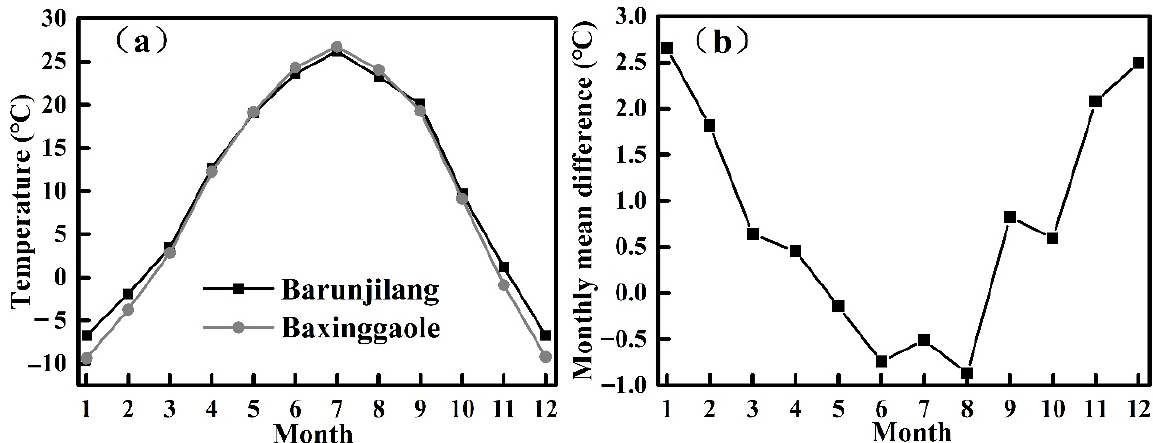
Figure 6. Annual temperature changes ( a ), monthly mean differences ( b ) in the lake and non-lake regions. Table 2. Comparison of temperature characteristics between lake and non-lake areas (unit: °C). Site T ave T min (Jan.) T max (Jul.)